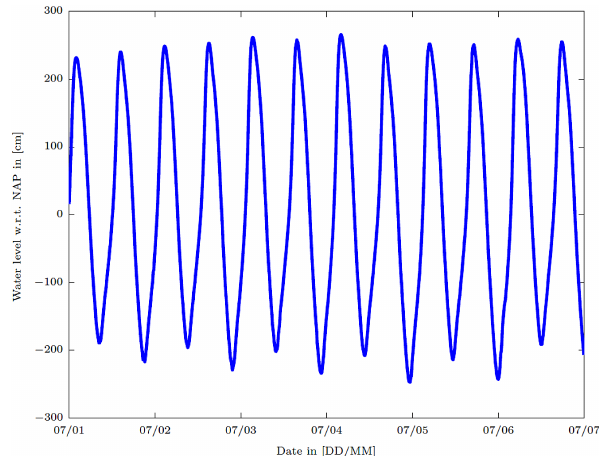
Figure 6. Observed water level at tidal measurement station Terneuzen from 1 to 6 July 2011.